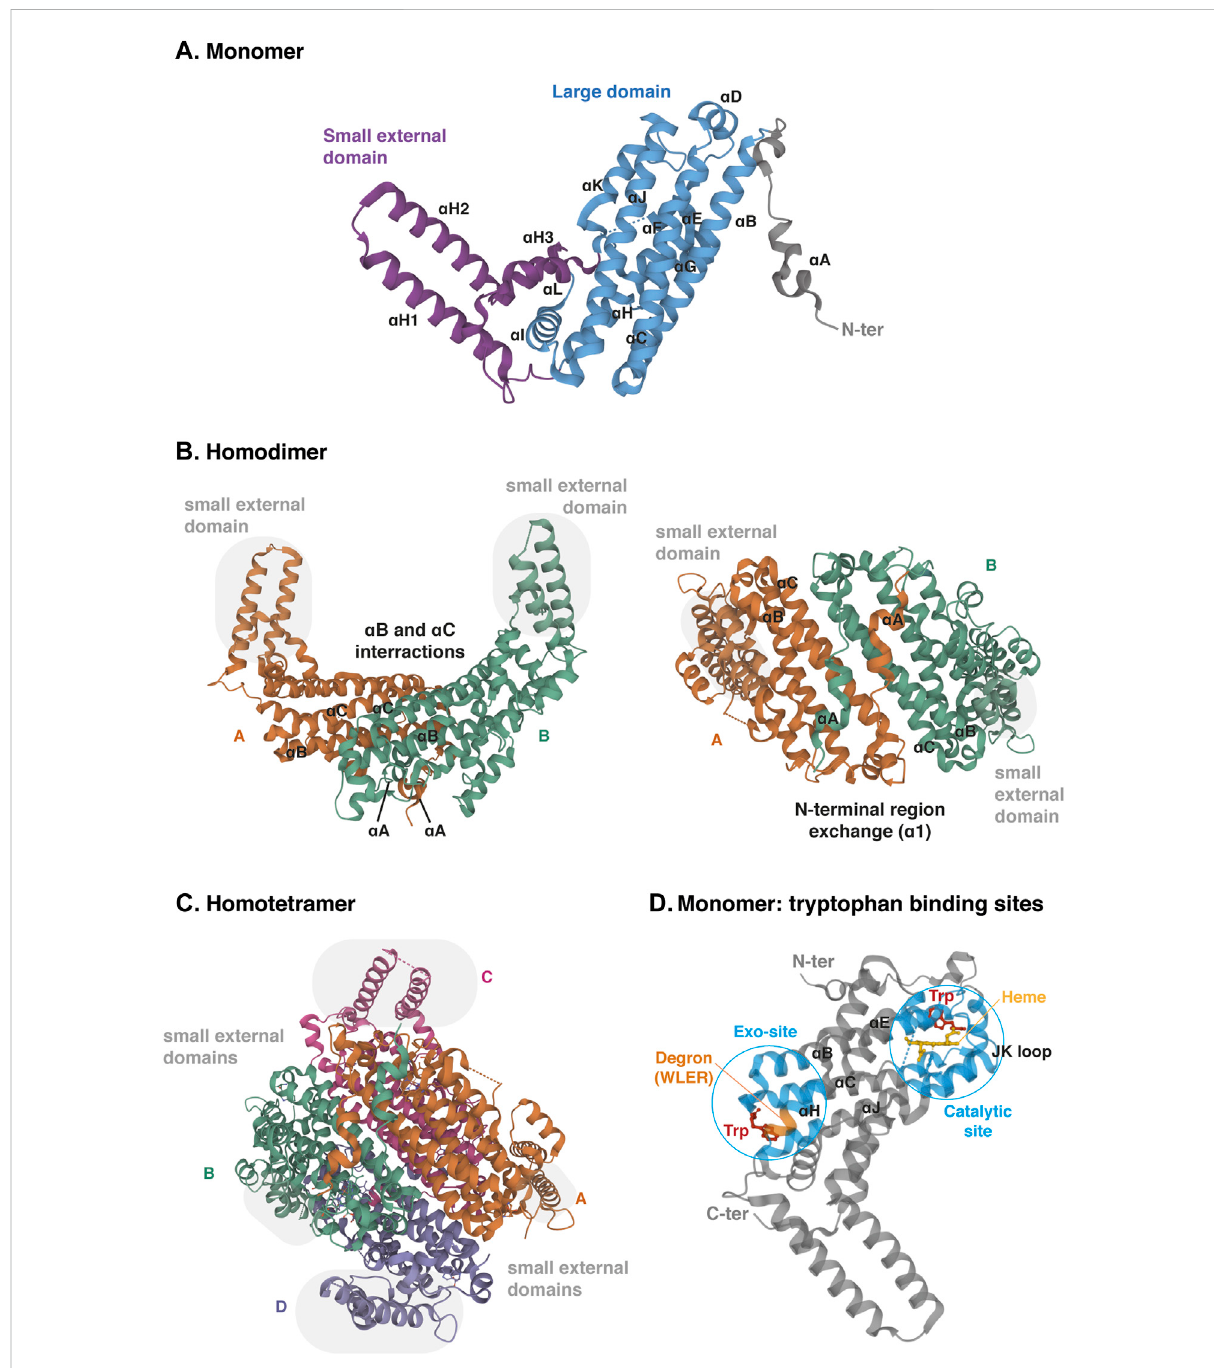
FIGURE 5 Crystal structure of human TDO (apo protein). (A) Monomeric conformation of TDO illustrating the secondary structure comprising fi fteen α -helices distributed in three parts: the large central domain (blue), the small external domain (purple) and the N-terminal region (grey). α -Helices are labeled α A- α L according to the TDO structure described by Lewis-Ballester and colleagues (Lewis-Ballester et al., 2016). (B) Homodimeric conformation of TDO in two orientations. Monomers are distinguishedby two colors. TDO monomers areassociated inpairs through the interactions of their α -helices B and C of thelargedomainsandthroughtheexchangeoftheir α -helicesAoftheN-terminalregions.Greyhighlightshowsthesmallexternaldomainsnotinvolvedin theinteractionofmonomersAandB. (C) HomotetramericconformationofTDO.Monomersaredistinguishedbyfourcolors.Dimersareclampedtogether through the interaction of their α -helices J. Dimer interaction is stabilized by the exchange of the small external domains (grey highlight) grafted on the oppositelargedomains(AwithCandBwithD,andviceversa). (D) MonomericconformationofTDOillustratingthetwotryptophan-bindingsites.TheTDO catalytic site (blue, right) is surrounded by the bundle from helices α B, α C, α J, α E and α H. The heme cofactor (yellow) is bound by the proximal His328 from α J. The TDO exo-site (blue, left) is also surrounded by the four-helical bundle from α B, α C, α J, α E and α H, opposite the catalytic site. The orange color inset indicatesthefour-aminoaciddegronmaskedbytryptophan,triggeringTDOdegradationinlowtryptophanemia(Klaessensetal.,2021).The3Dstructureof TDO was modelized with Mol* Viewer from the crystal structure of TDO described by Lewis-Ballester et al. (2016) (PDB fi le ID: